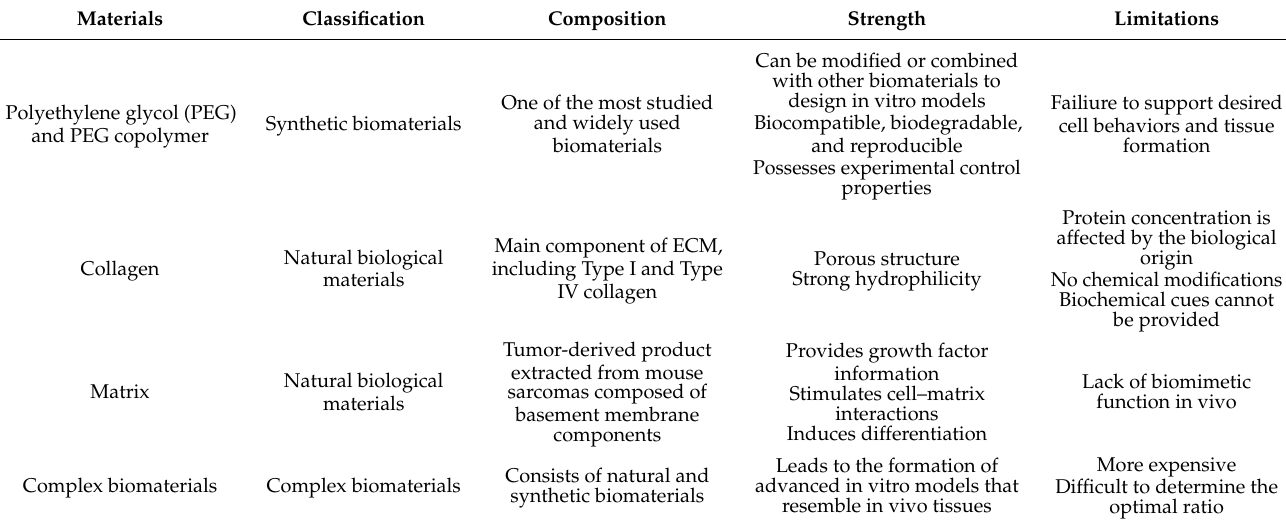
Table 2. Commonly used biological materials [19,20].